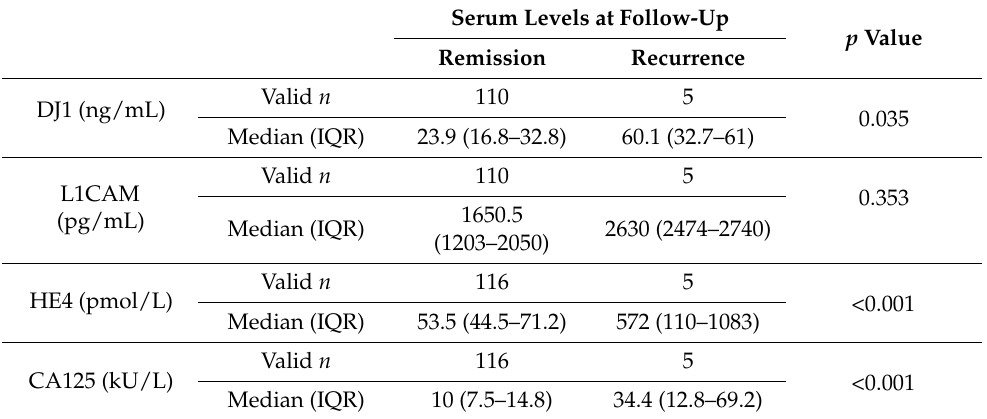
Table 4. DJ1, L1CAM, HE4 and CA125 follow-up serum levels in patients with or without recurrence of endometrial cancer.